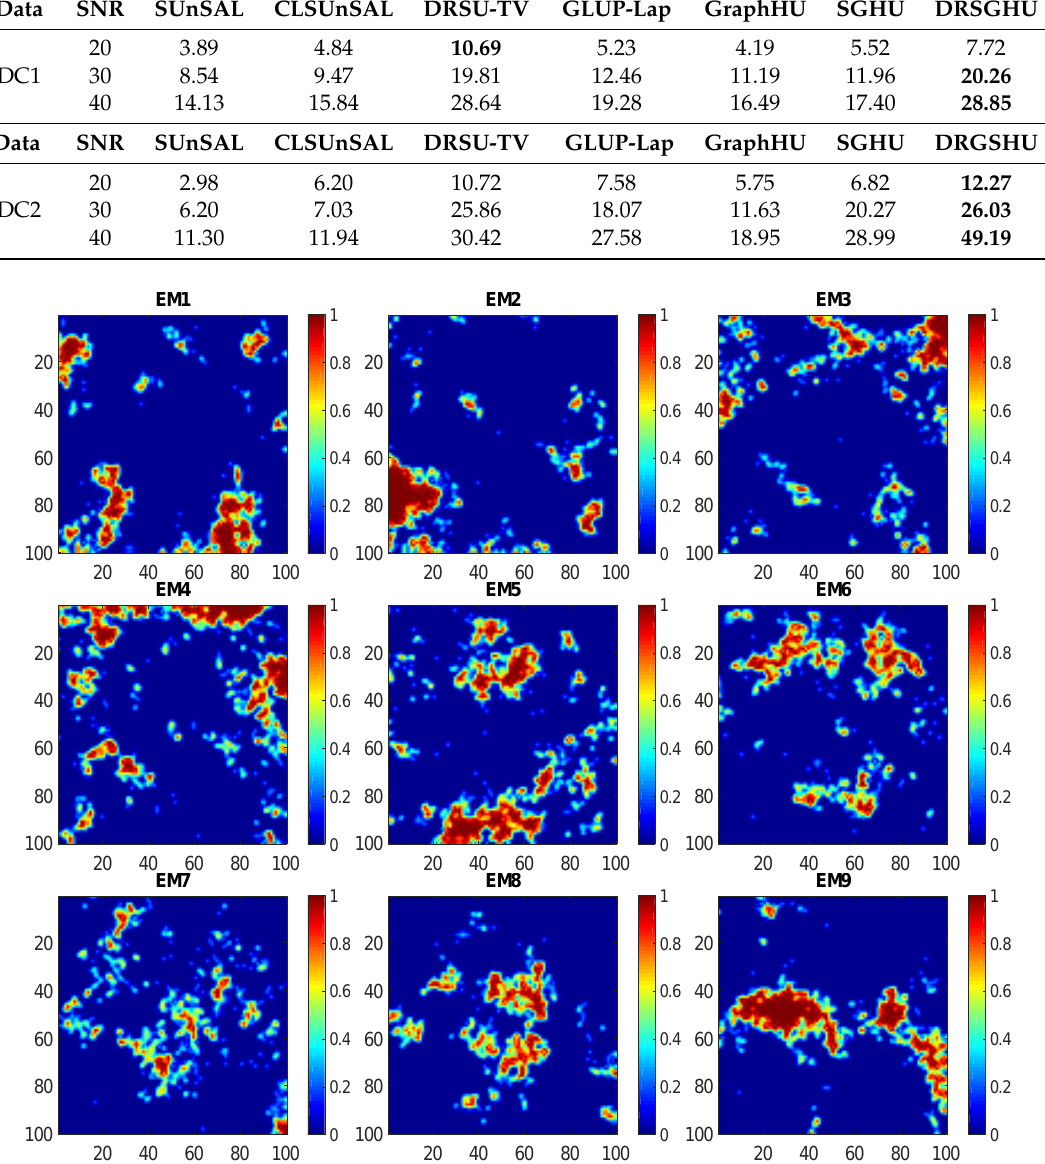
Table 1. SRE (dB) values achieved by different methods for noise levels 20 dB, 30 dB and 40 dB on all simulation data.